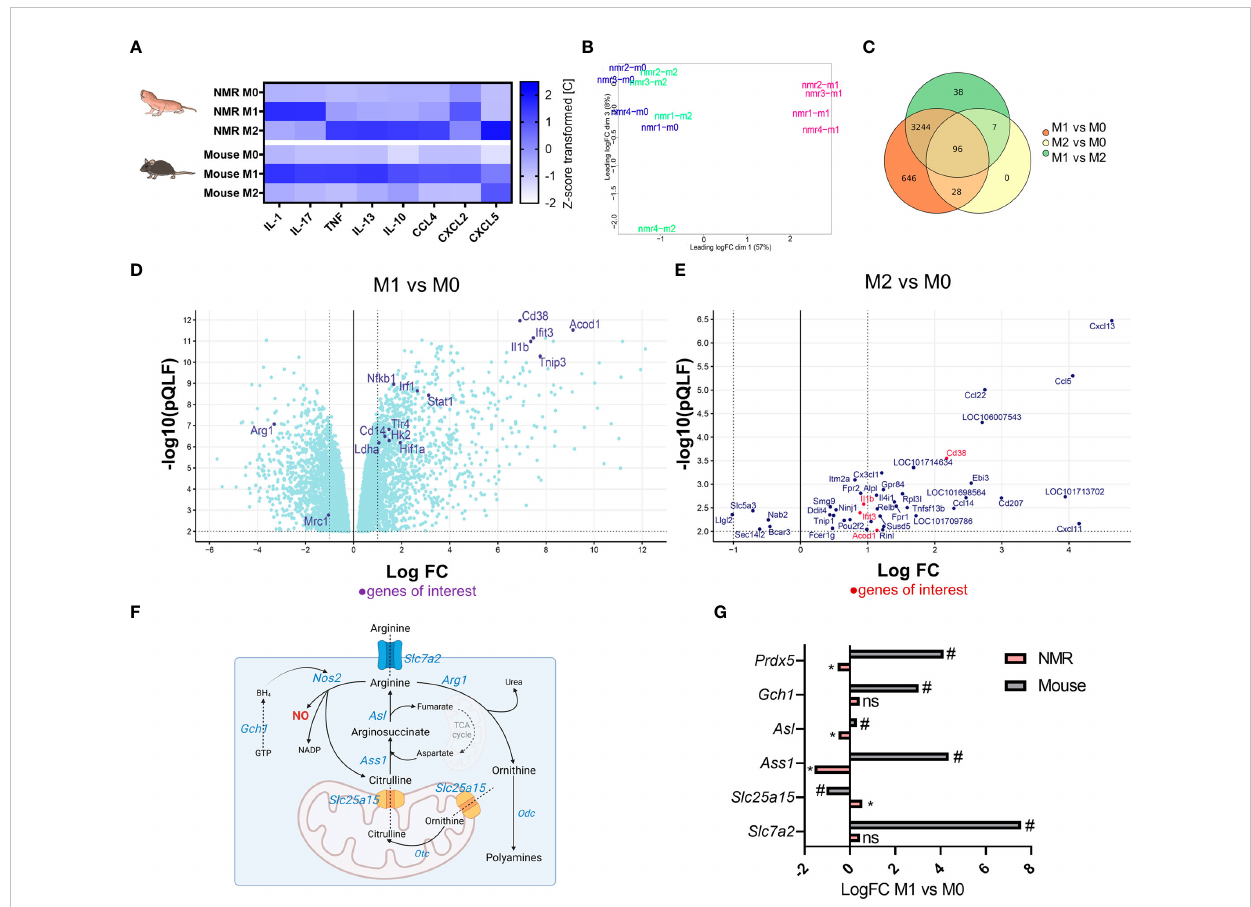
FIGURE 6 Distinct transcriptional and secretion pro fi les of NMR M1 and M2 macrophages (A) Multiplex immunoassay on the samples of M0, M1, and M2 supernatants of NMR (n=5) and mouse (n=3) macrophages, each cell shows mean of z-score transformed cytokine concentration in medium (pg/ mL). (B) MDS plot for NMR M0, M1, M2 transcriptomic pro fi les; (C) Venn diagrams of DEGs in NMR M0, M1, M2 (D) Volcano plot of DEG in NMR M1 to M0, only DEG with p < 0.01 (QLF test) are displayed (E) Volcano plot of DEG in NMR M2 to M0, only DEG with p < 0.01 (QLF-test) are displayed. (F) NO-Urea cycle and aspartate-argininosuccinate shunt schematic representation with the depiction of genes involved and their logFC in M1 as compared to M0 cells in NMR (pink) and mouse (grey) (G) . * p<0.05 (QLF-test) in NMR; # p<0.05 (QLF-test) in mouse, ns, not signi fi